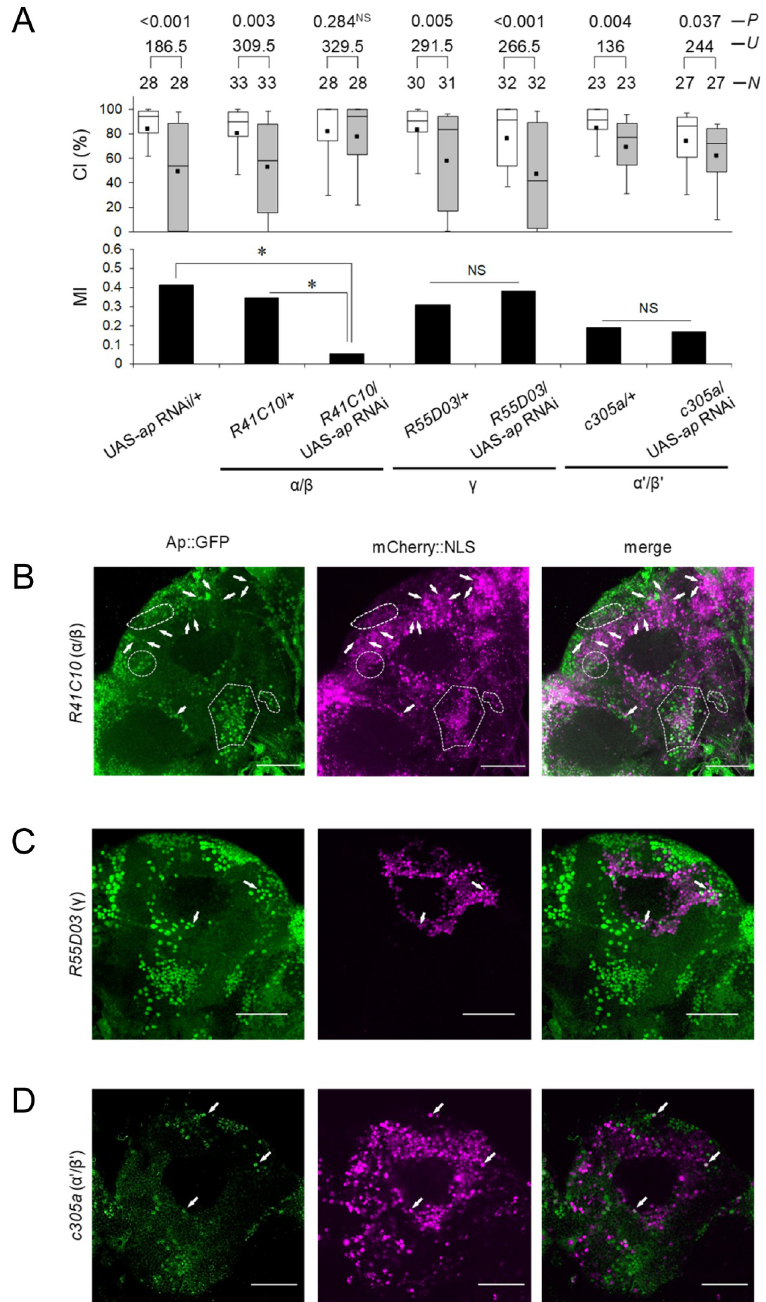
Fig 2. ap knockdown in MB α / β neurons induces LTM impairment. (A) Five-day memory after 7-hour conditioning. ap RNAi was driven by MB α / β -GAL4 ( R41C10 ), MB γ -GAL4 ( R55D03 ), and MB α ’/ β ’-GAL4 ( c305a ). Box plots for a set of CI data show 10th, 25th, 75th, and 90th centiles. In the box plots, the black square in each box indicates the mean, the line in each box is drawn at the median, the white boxes indicate naive males, and the gray boxes indicate conditioned males. The underlying data can be found in S1 Data. CI, courtship index; MI, memory index; N , sample size; U , Mann–Whitney U ; P , probability; � , P < 0.05; NS, not significant. (B–D) Ap-expressing neurons in MBs. Confocal sectional images at the level of Kenyon cells in MBs. Scale bars, 50 μ m; green, Ap::GFP; magenta, mCherry::NLS driven by MB-GAL4 lines. Dotted lines and arrows show the colocalization of Ap::GFP and mCherry::NLS. (B) ap :: GFP /+; UAS- mCherry :: NLS / R41C10 flies were used. (C) ap :: GFP / + ;UAS- mCherry :: NLS / R55D03 flies were used. (D) ap :: GFP / c305a ; UAS- mCherry :: NLS / + flies were used. Ap, Apterous; LTM, long-term memory; MB, mushroom body; RNAi, RNA